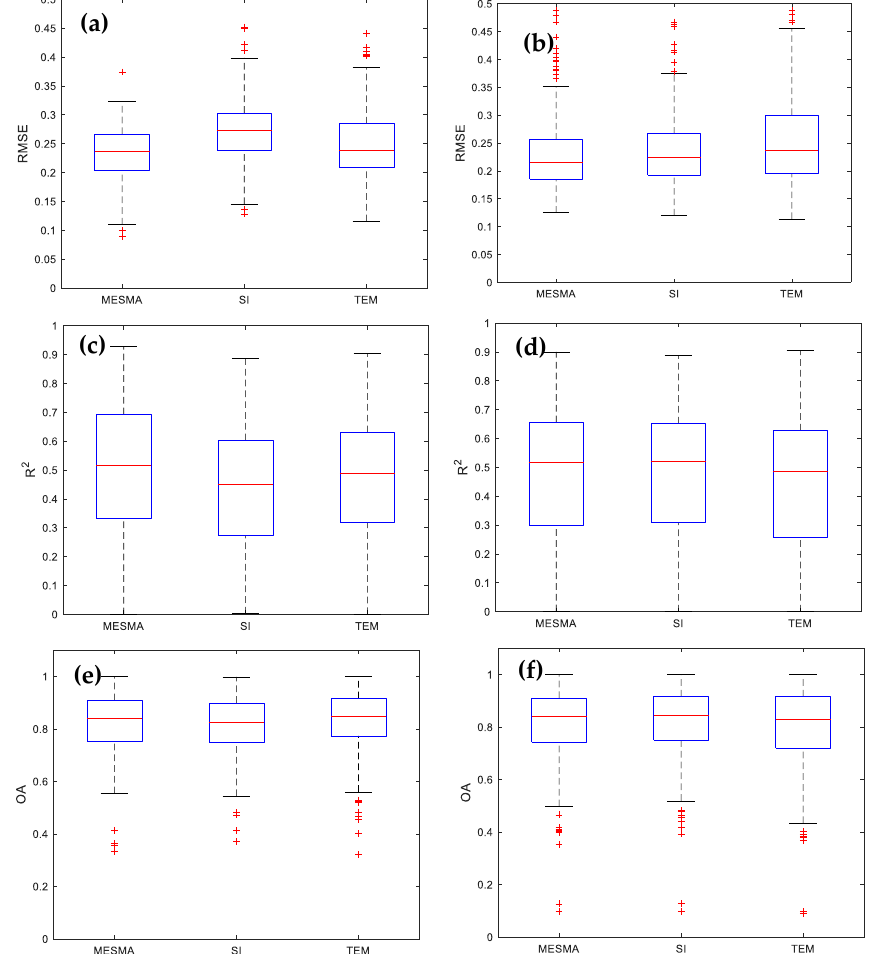
Figure 5. Boxplots of accuracy evaluation results for three AVHRR/2 fractional-snow-cover retrieval algorithms at 1 km and 5 km scales, based on 313 Landsat-5/TM scenes: ( a ) the RMSE of the three AVHRR/2 FSC retrieval algorithms at 1 km scale; ( b ) the RMSE of the three AVHRR/2 FSC retrieval algorithms at 5 km scale; ( c ) the R 2 of the three AVHRR/2 FSC retrieval algorithms at 1 km scale; ( d ) the R 2 of the three AVHRR/2 FSC retrieval algorithms at 5 km scale; ( e ) the OA of the three AVHRR/2 FSC retrieval algorithms at 1 km scale; ( f ) the OA of the three AVHRR/2 FSC retrieval algorithms at 5 km scale.